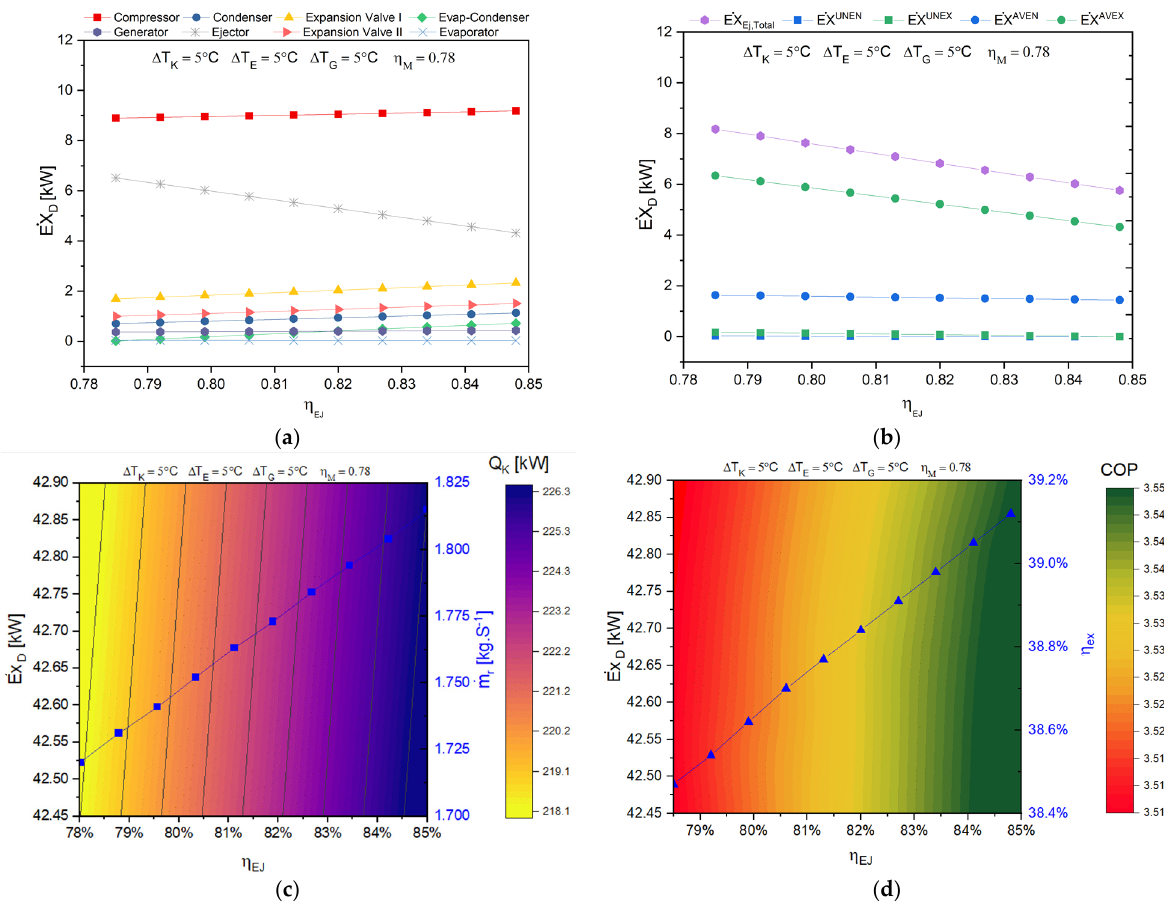
Figure 11. Ejector efficiency variation influence: ( a ) components exergy exogenous part, ( b ) ejector exergy destruction parts, ( c ) refrigerant mass flow rate, and ( d ) system COP-exergy efficiency.